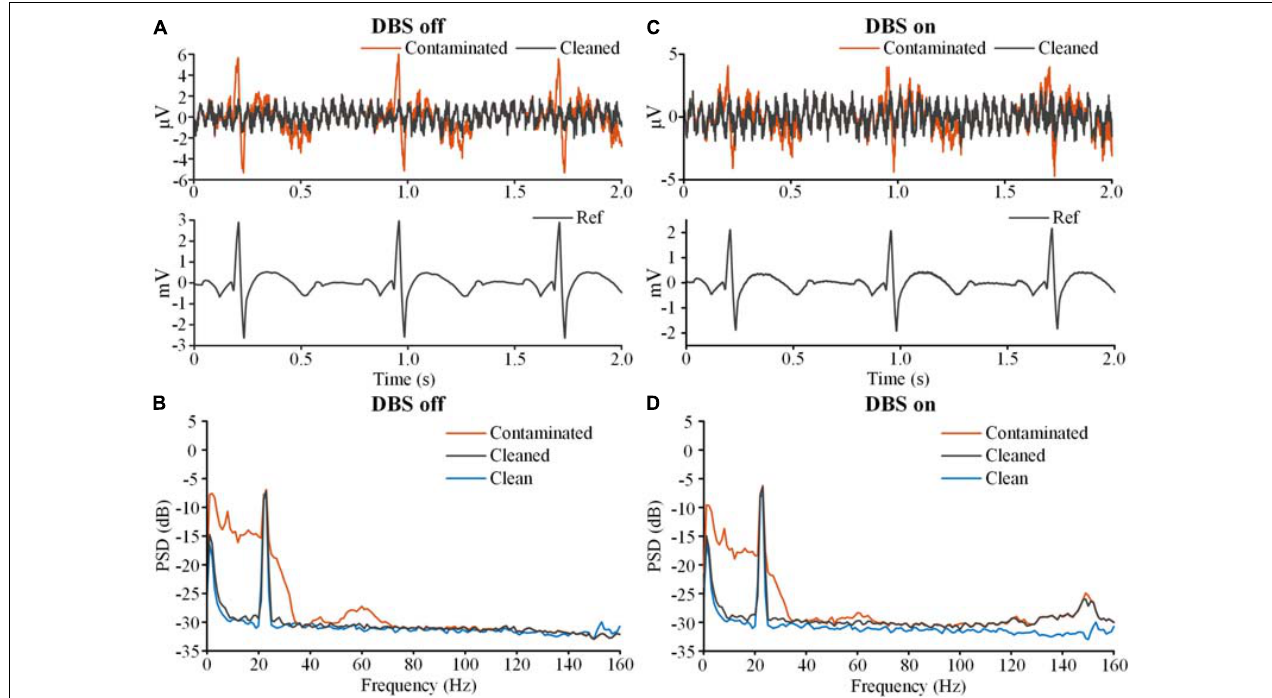
FIGURE 6 | The results of ECG artifact removal using template subtraction. (A) The results of ECG removal with the DBS off. The bipolar recordings before (contaminated, red line) and after (cleaned, gray line) ECG removal were plotted on the top axis. The monopolar recording of the ECG reference was plotted on the bottom axis. (B) The PSDs of the bipolar recording before and after ECG removal. The blue line is the PSD of the clean LFP. (C) The results of ECG removal fromthe recording with the DBS on. (D) The PSDs of the bipolar recordings before and after ECG